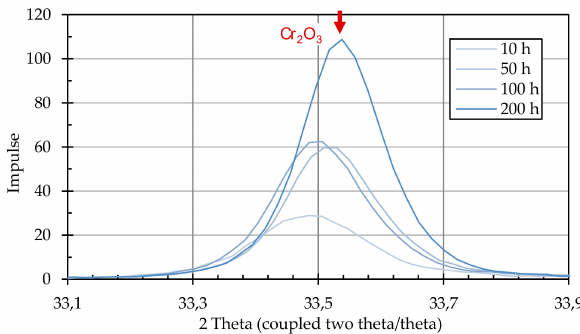
Figure 15. XRD measurement of Inconel 617 with identification of the decisive compounds (Cr 2 O 3 , base material).